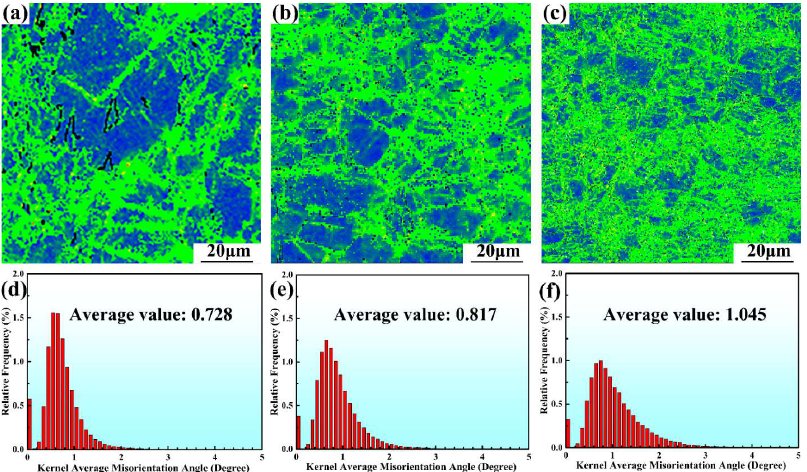
Figure 4. KAM maps of ( a ) R30 alloy; ( b ) R50 alloy; and ( c ) R70 alloy. Statics of KAM angle in ( d ) R30 alloy; ( e ) R50 alloy; and ( f ) R70